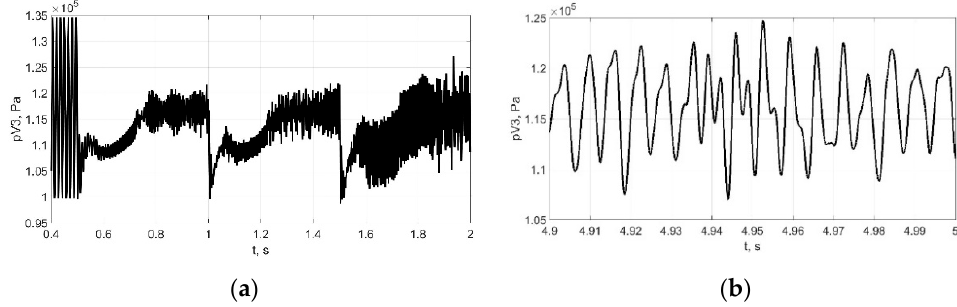
Figure 12. Pressure in the Pipeline Unit of the LNG transportation system: ( a ) the beginning of the simulation time; ( b ) the end of simulation.